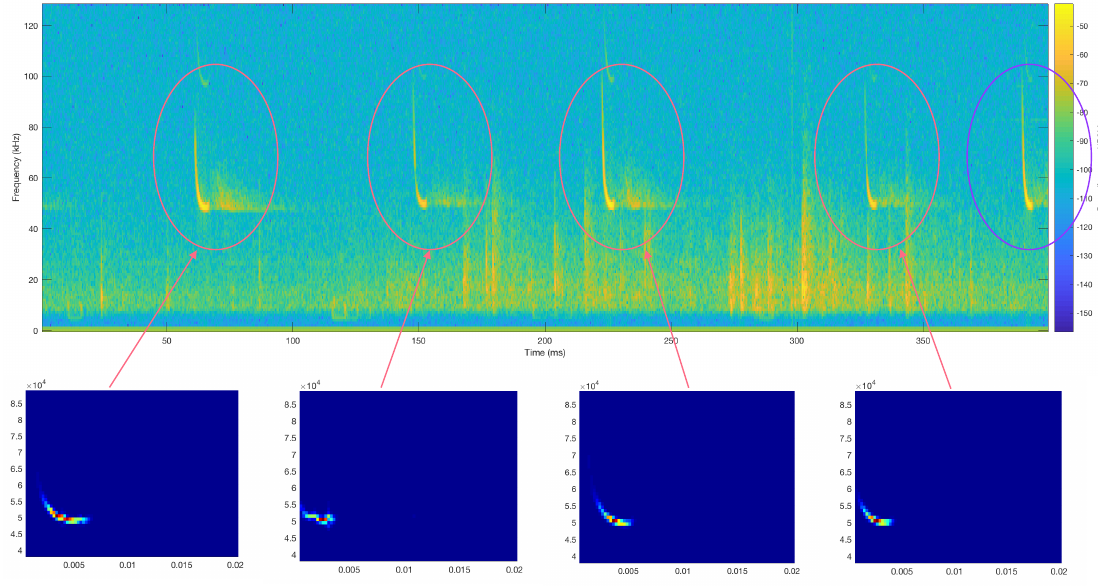
Figure 11. Original spectrogram matrix of a sample audio file and the extracted matrix parameterizations of each call pulse. Each highlighted pulse is associated with the corresponding extracted matrix but the purple one, which does not meet with the parameterization